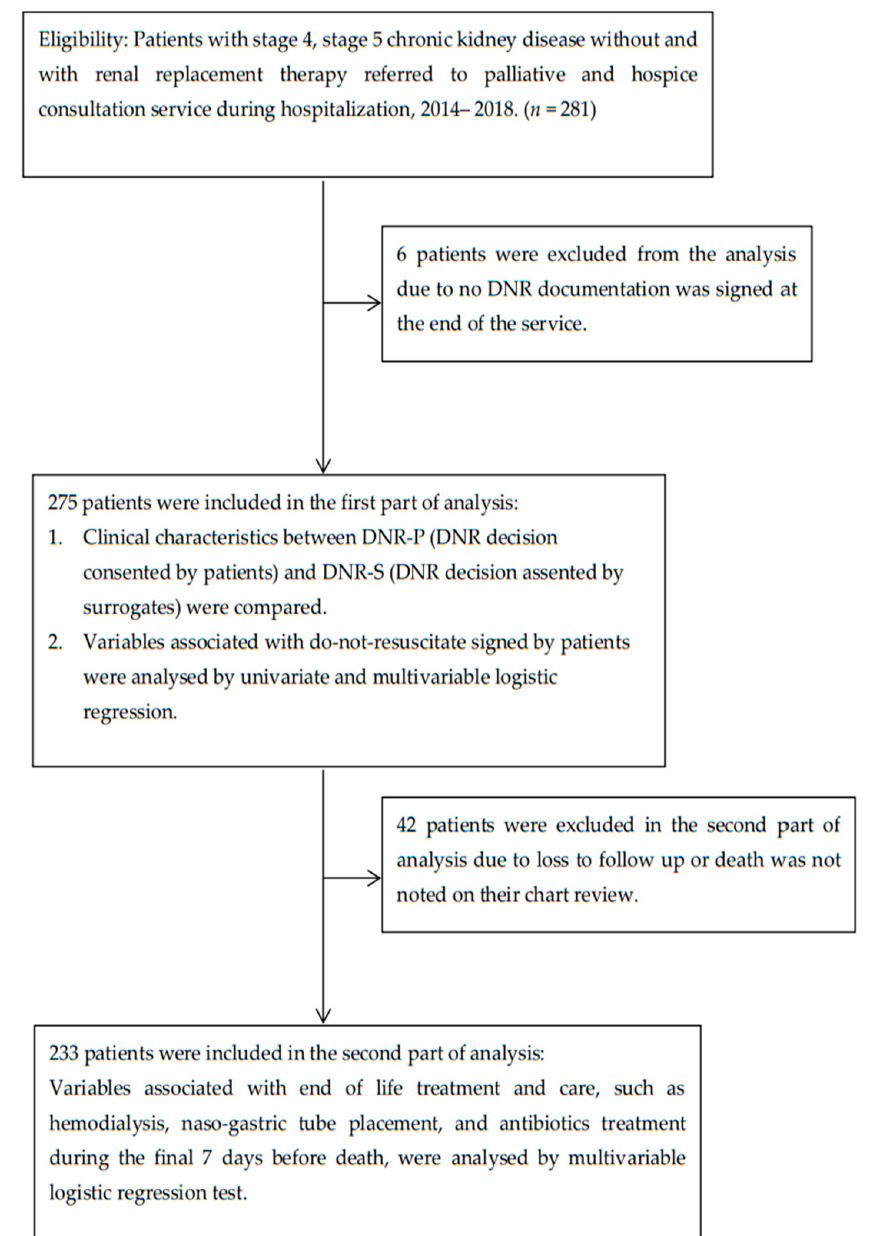
Figure 1. Patient enrollment and exclusion; DNR = do-not-resuscitate.